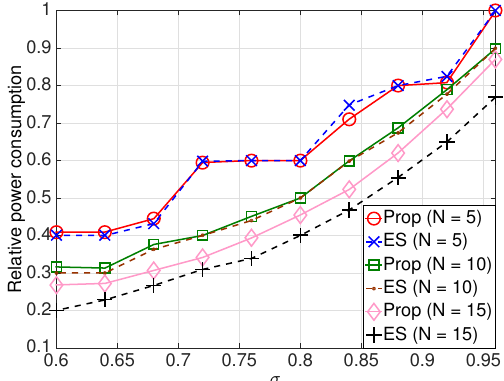
Figure 6. Relative power consumption of FBSs vs. σ by varying N